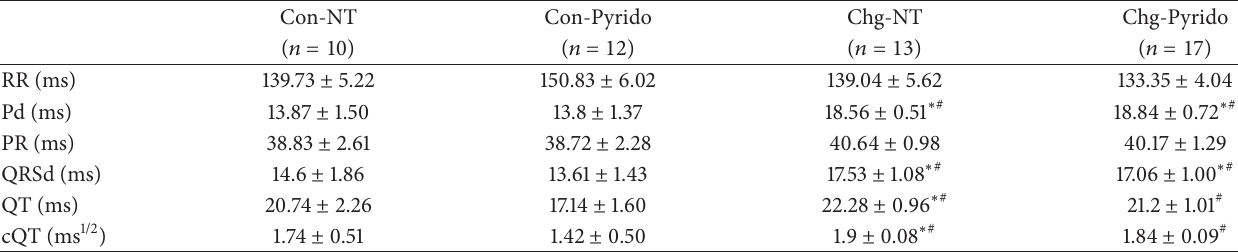
Table 1: Electrocardiogram before treatment with pyridostigmine bromide. Electrocardiographical parameters (expressed as mean ± S.E.M.) collected after five months follow-up in noninoculated control (Con) or T. cruzi- inoculated (Chg) anesthetized C57BL/6j mice before treatment with pyridostigmine bromide (Pyrido) or vehicle (NT: nontreated animals). Con-NT